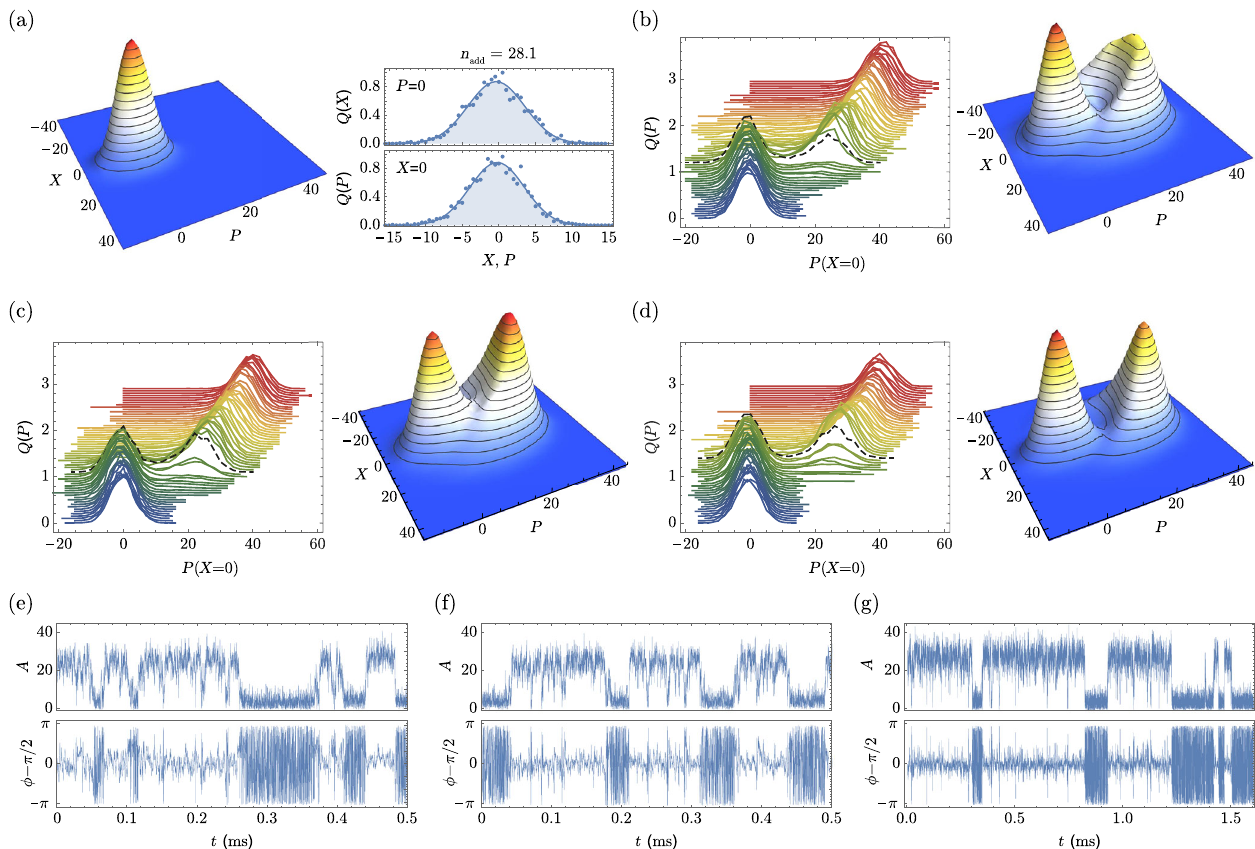
FIG. 4. (a) Measured Q function of the vacuum field for very low drive power η = ð 2 π Þ ¼ 1 . 4 MHz in the photon-blockade regime (left) and Gaussian fit along the two field quadratures X and P . The fit reveals a thermal state due to the added amplifier noise with 28 . 1 . (b) The waterfall plot shows line cuts of the measured Q functions, where X ¼ 0 as the drive strength is increased from n add ¼ η = ð 2 π Þ ¼ 1 . 4 to 11 MHz for a single transmon in resonance with the cavity (left). A vertical offset of 0.05 between the line plots is used for better visibility. The complete Q function for the critical drive strength η = ð 2 π Þ ¼ 7 . 1 MHz, which is indicated by the dashed black line on the left. (c) The same measurement for transmons 1 and 2 in resonance and the critical drive strength η = ð 2 π Þ ¼ 6 . 8 MHz. (d) The same for transmons 1, 2, and 3 in resonance and the critical drive strength η = ð 2 π Þ ¼ 7 . 7 MHz. (e) – (g) The real-time single-shot record of the transmitted output field amplitude and phase for one (e), two (f), and three (g) atoms in resonance with the